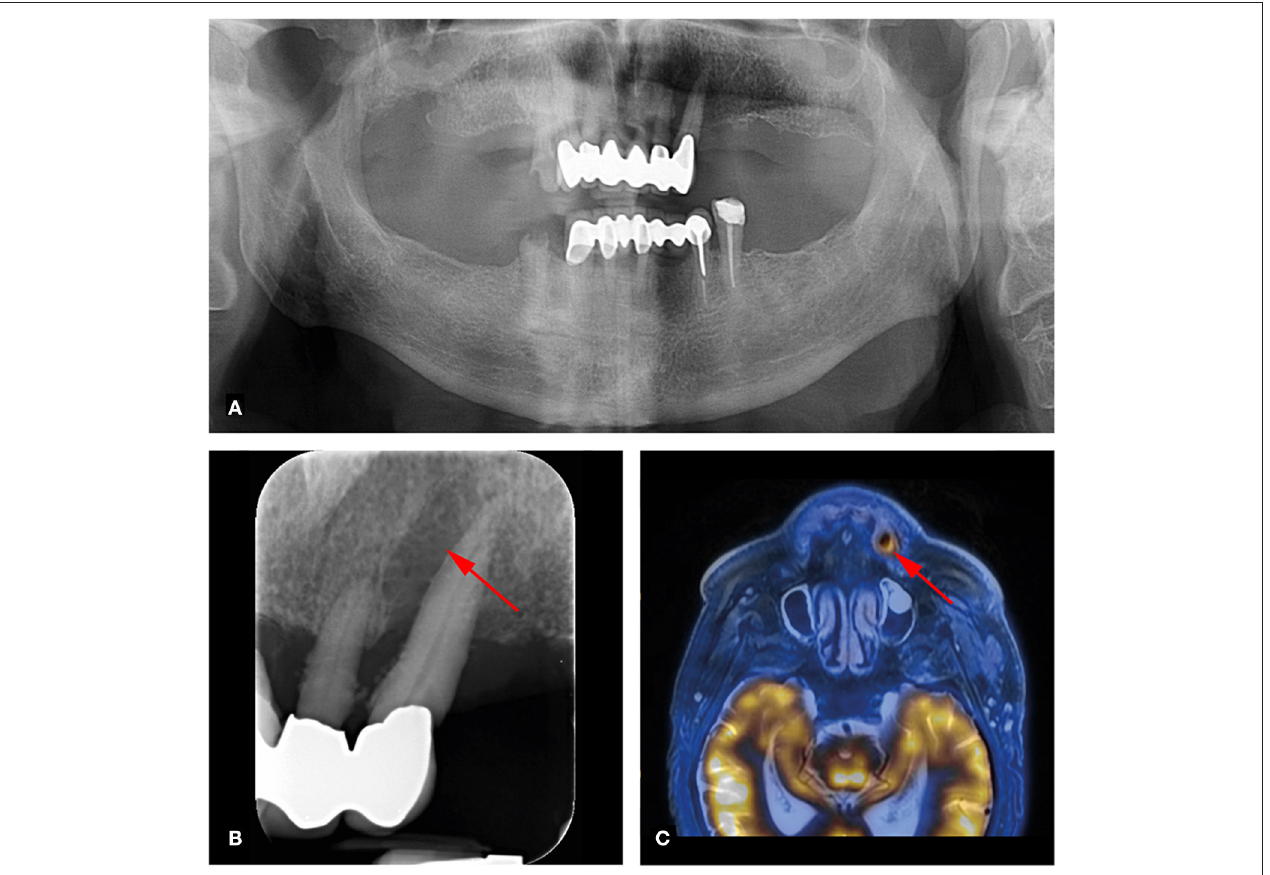
TABLE 1 | Periapical lesions (PL) in dental X-rays and FDG-PET/MR. PAI Score PL in dental radiographs PL in PET/MR PL with increased PL in dental radiographs > 5mm ( n = 2) ( n = 23) ( n = 19) SUV max ( n = 1)